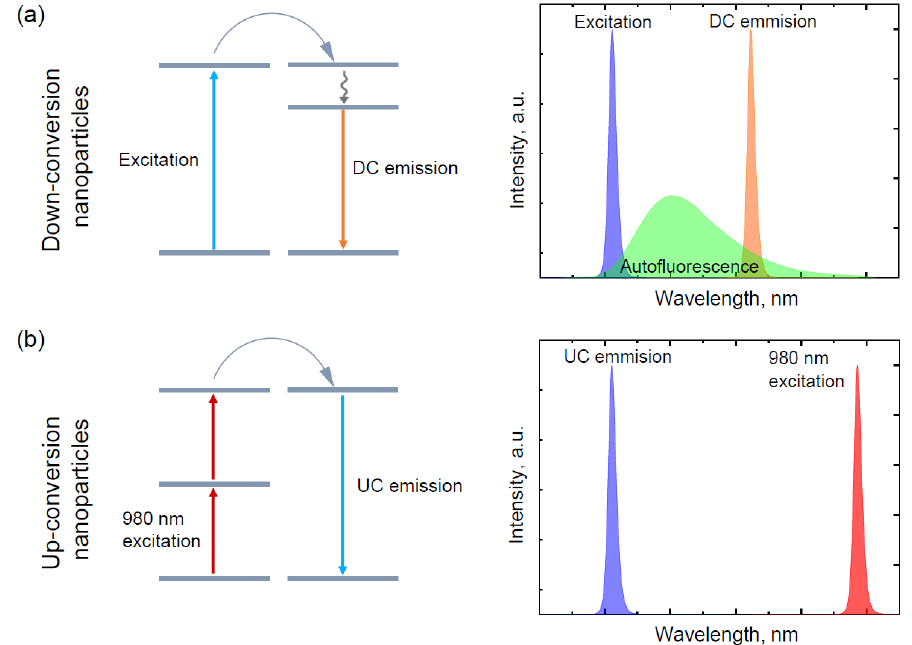
Figure 6. Schematic illustrations of underling luminescence mechanisms: ( a ) down-conversion nanoparticles are excited in the region where various biomolecules also could be excited and the emission of nanoparticles could overlap with autofluorescence; ( b ) up-conversion nanoparticles are excited in NIR region where biomolecules are not excited, thus there is no autofluorescence of the sample. Gorris et al. described UCNPs as background-free codes for multiplexed analyses [86]. In